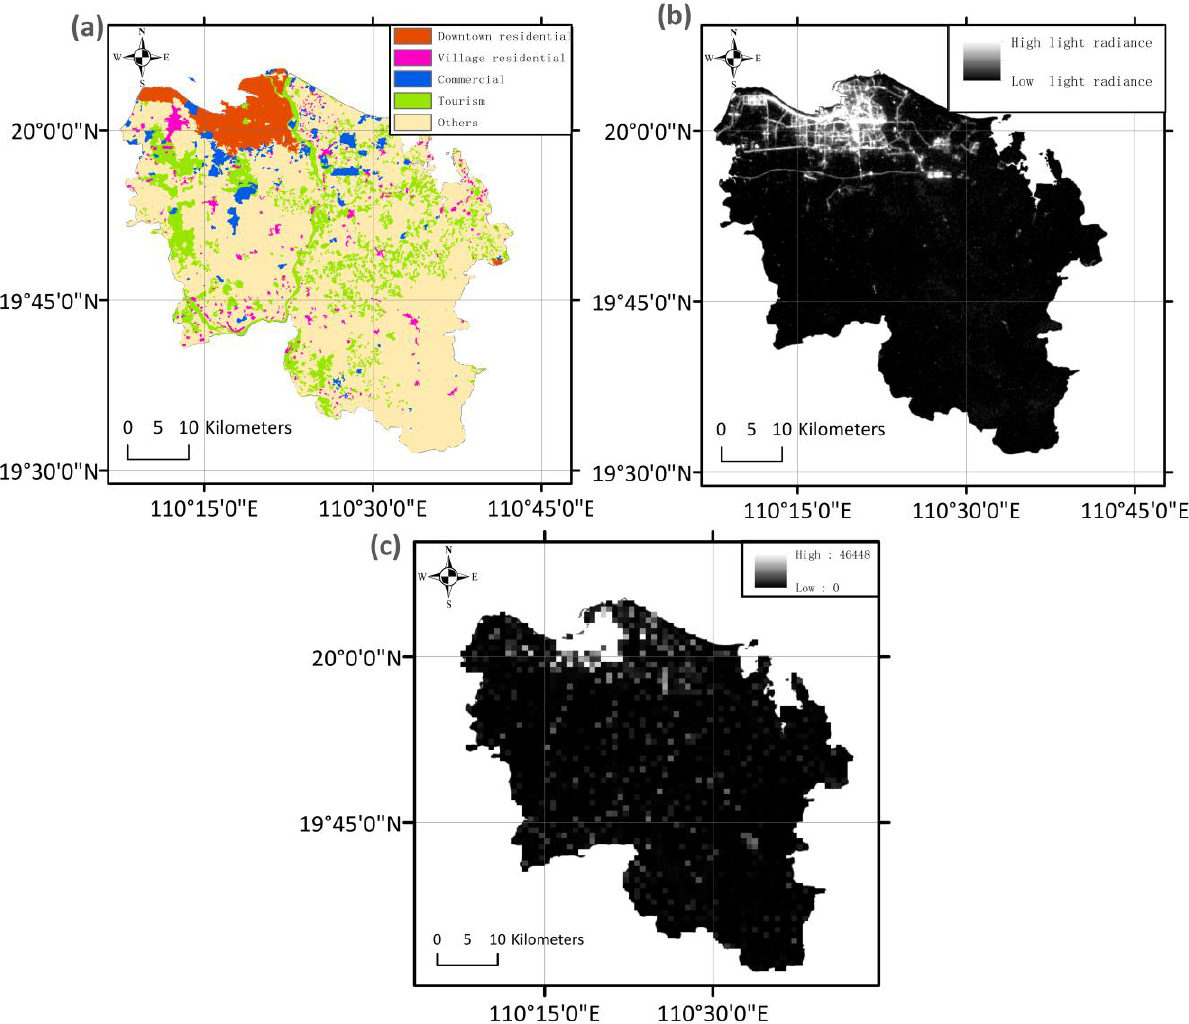
Figure 2. ( a ) Land use classifications in Haikou (2018). The map contains downtown residential, village residential, commercial, tourism and other land use types; each type is marked with a different color. ( b ) Nighttime remote sensing image of Haikou city captured by the LJ1-01 satellite (4 September 2018, as an example), the resolution of the map is 130 m. The image spans the latitudes and longitudes of 19°30′ N to 20°15′ N and 110°0′ E to 110°45′ E. In the map, the brighter the color, the higher the luminous intensity; the highest value is 973,851 W/(m 2 ∙ sr ∙ μm) . ( c ) Population distribution map of Haikou (2010). The resolution of the map is 1 km. Population density and LJ1-01 nightlight remote sensing intensity shows a highly linear positive correlation, with R-square of 0.73. Table 1. Subclass of each land use type.